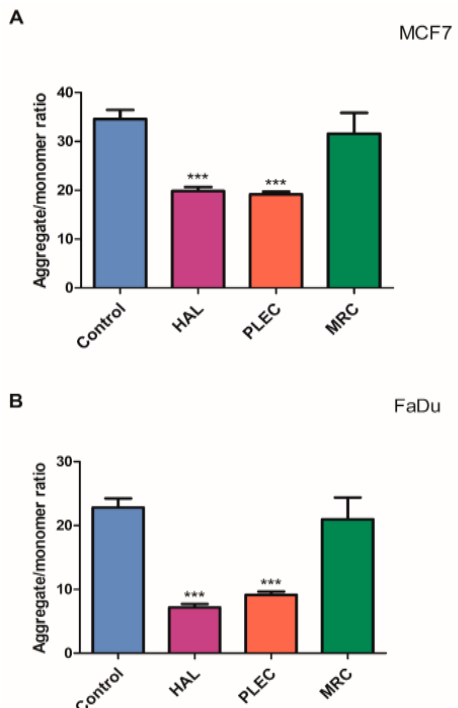
Figure 4. Changes in mitochondrial membrane potential of ( A ) MCF7, ( B ) FaDu cells incubated with HAL, PLEC and MRC for 24 h. Results are presented as means ± SD. *** statistically significant changes compared with control cells ( p < 0.001).